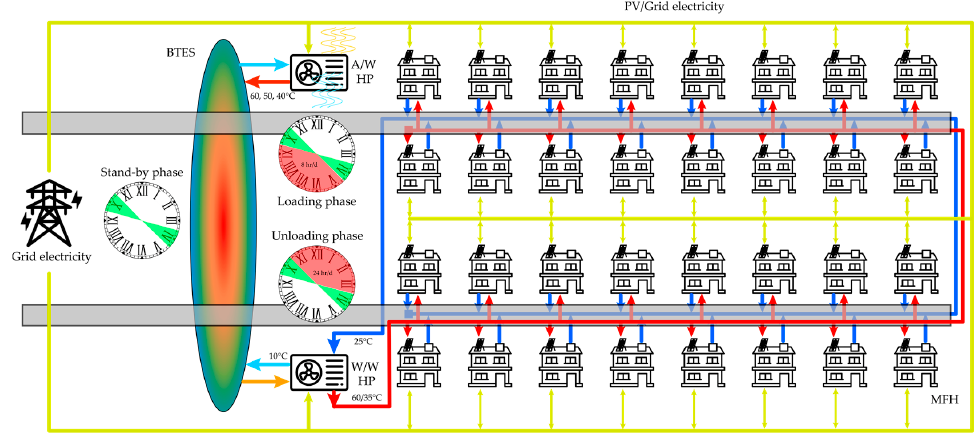
Figure 15. DHN with 3D-HDD BTES systems.